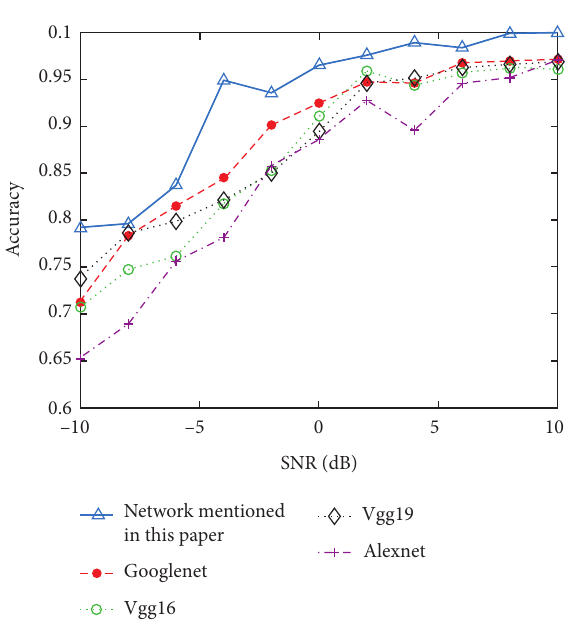
Figure 9: Variation curves of test recognition accuracy varying with SNR for different